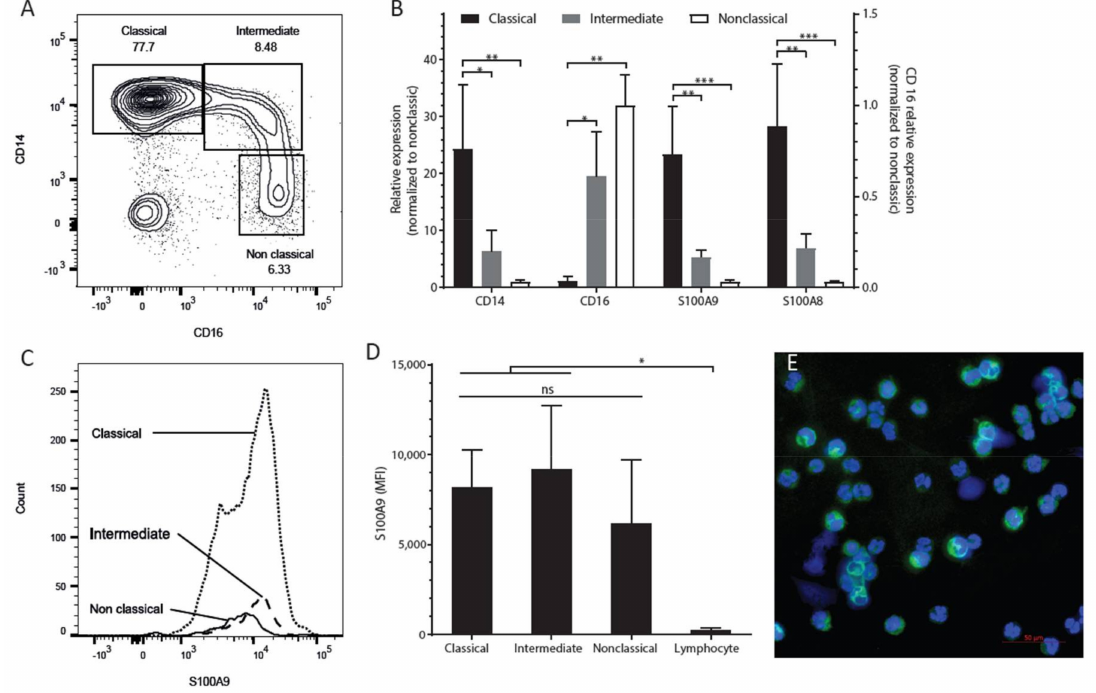
Figure 1. S100A9 expression is highest in CD14+ classical monocytes. ( A ) Classical, intermediate, and nonclassical monocytes subsets were sorted based on CD14 and CD16 expression using FACS; ( B ) The relative expression of S100A9 in the classical subset was 20-fold higher than that in the non-classical subset; ( C ) The representative FACS histogram plot showed that S100A9 expression in the three monocyte subsets overlapped with each other; ( D ) The median fluorescence intensity (MFI) of S100A9 in the classical subset was approximately twice as high than that in the non-classical subset; ( E ) The cytospin results showed that the fluorescence intensity varied greatly between individual cells within the CD14+ monocyte population; scale bar: 50 µ m. The differences were tested by one-way ANOVA with Tukey’s multiple comparison tests. Data are expressed as means ± SD of at least three biological replicates. * p < 0.05, ** p < 0.01, *** p <